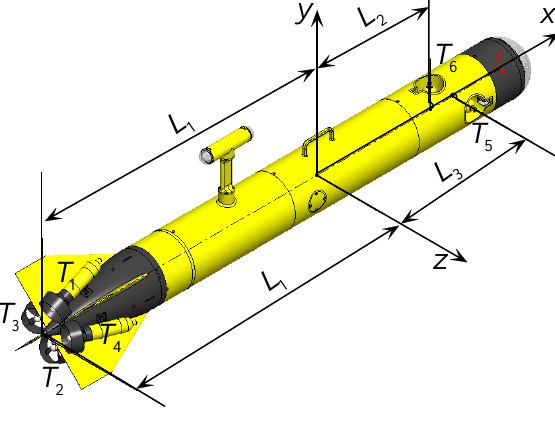
Figure 3. Thruster arrangement. Figure 3. Thruster